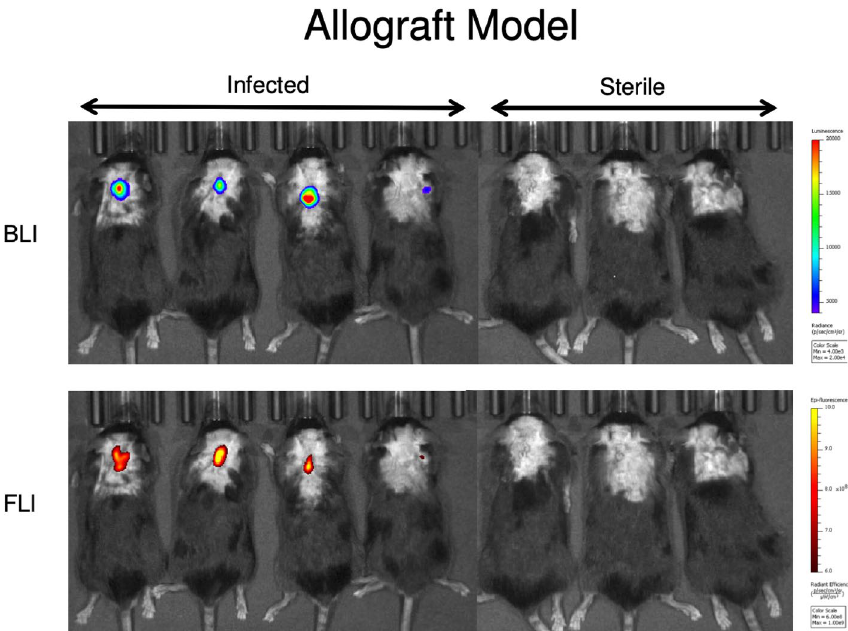
Figure 7. Bioluminescence and fluorescence imaging of mice with a spinal allograft infection 72 h post 1D9-680 probe injection. At 72 h PI of the 1D9-680 probe, co-localization of the probe in 4 mice with infected dorsally placed cancellous human allograft implants is evidenced by bioluminescence and fluorescence imaging as described for Fig. 3. As expected, neither bioluminescence nor fluorescence are detectable in the 3 control mice with sterile allograft implants.